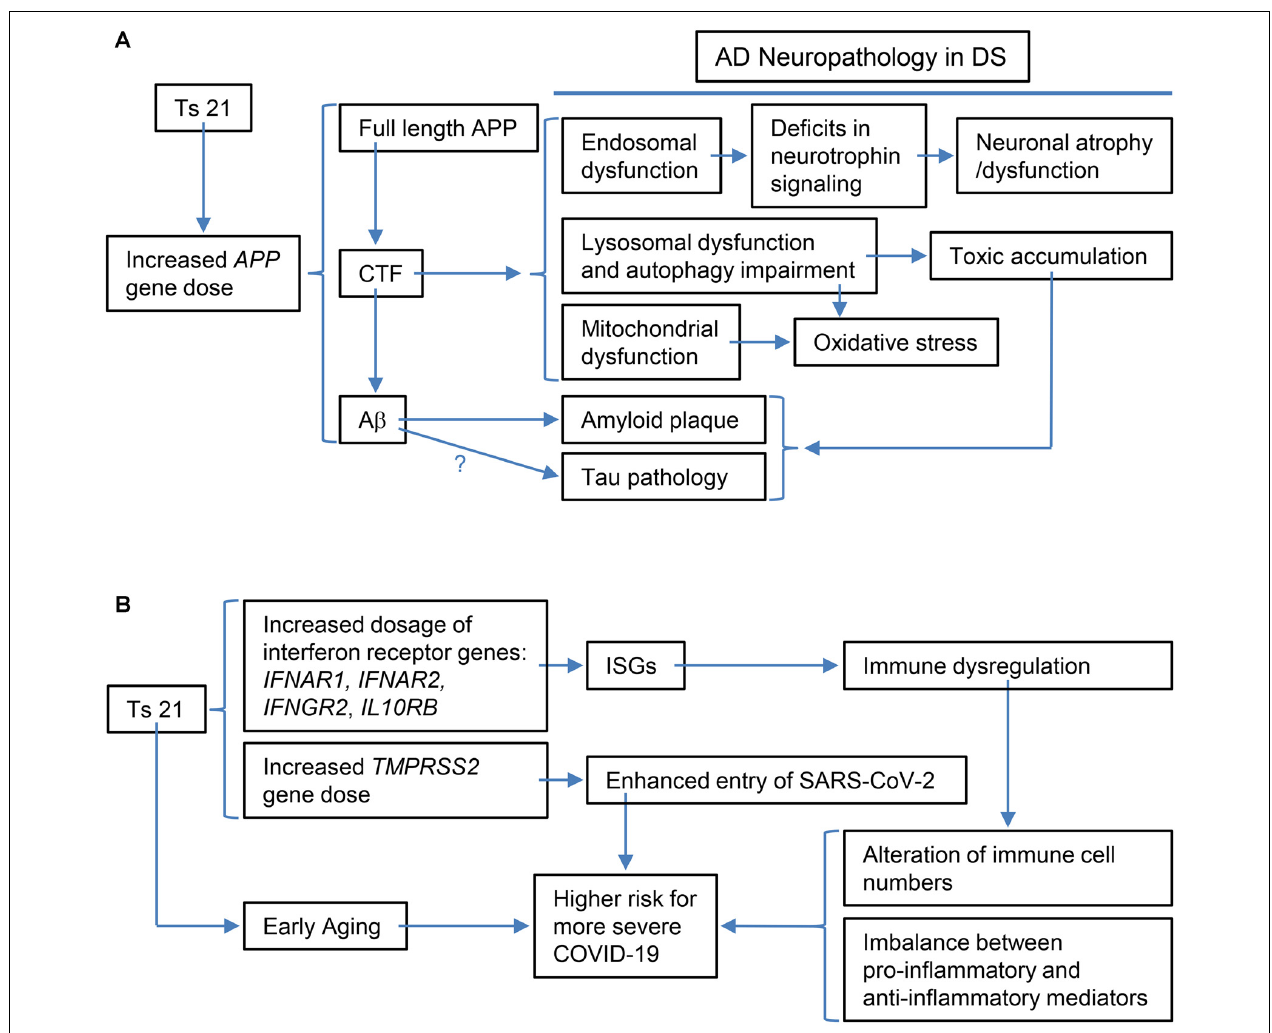
FIGURE 2 | Schematic representations of the specific examples of the relationship between the triplication of Hsa21 or Hsa21 gene ortholog(s) and its phenotypic consequences at various levels. (A) The triplication of the APP ortholog and its impacts on Alzheimer’s disease (AD)-related phenotypic features: increased APP gene dose in DS leads to increases in full-length APP protein and its products, including CTF ( α -CTF and β -CTF) and A β peptides of varying length. Accumulating evidence points to β -CTF as driving endosomal dysfunction, lysosomal dysregulation, autophagy impairment as well as mitochondrial dysfunction. Abnormal early endosomes may contribute to deficits in the retrograde axonal transport of neurotrophic signaling in several neuron populations, including BFCNs, thus compromising their trophic support and leading to neuronal dysfunction and atrophy. Lysosomal dysregulation and autophagy impairment can allow for the build-up of toxic proteins and induce oxidative stress due to failed clearance of organelles, including mitochondria. β -CTF accumulation could also lead to mitochondrial dysfunction. In addition, increased A β peptides contribute to amyloid plaque formation; evidence supports a role for A β in tau pathology, but as yet there is no direct demonstration for this in DS. Autophagy-lysosomal system dysfunction also contributes to amyloid and tau pathologies. (B) The triplication of Hsa21 or Hsa21 gene orthologs and its impacts on the immune system and COVID-19 in the DS population: The dosage increase of the four interferon receptor genes in Ts21, IFNAR1 , IFNAR2 , IFNGR2 , and IL10RB , up-regulates expression of interferon-stimulated genes (ISGs), which in turn results in immune dysregulation, including alteration of immune cell numbers as well as an imbalance between pro-inflammatory and anti-inflammatory mediators. These changes in DS are likely related to a higher risk for more severe COVID-19, which may also be contributed by the dosage increase of TMPRSS2 and early aging. BFCNs, basal forebrain cholinergic neurons; α -CTF, C-terminal APP fragment of 83 amino acids.